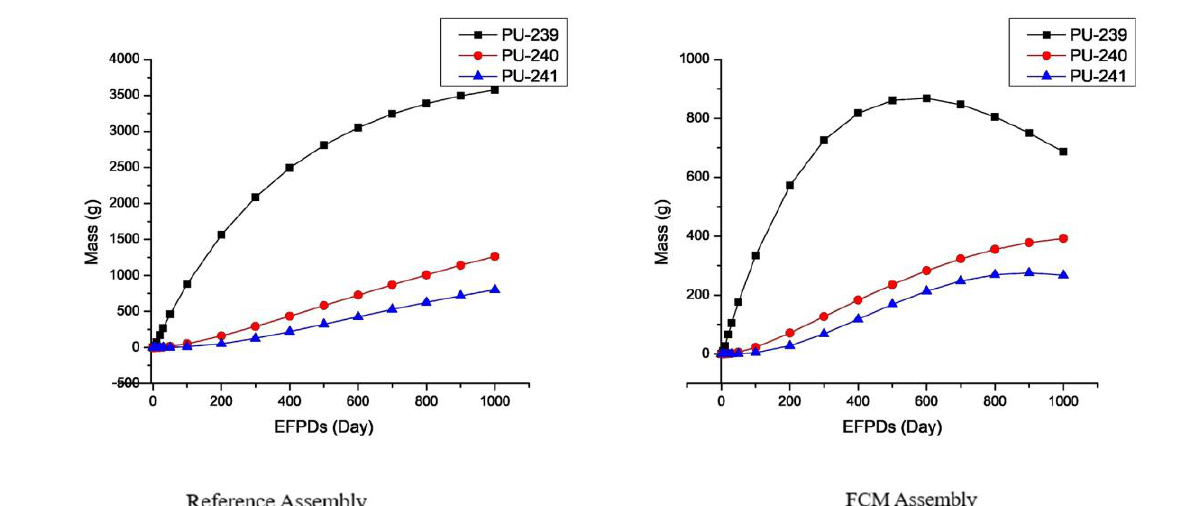
Figure 6. Material inventories of Reference and FCM assemblies.